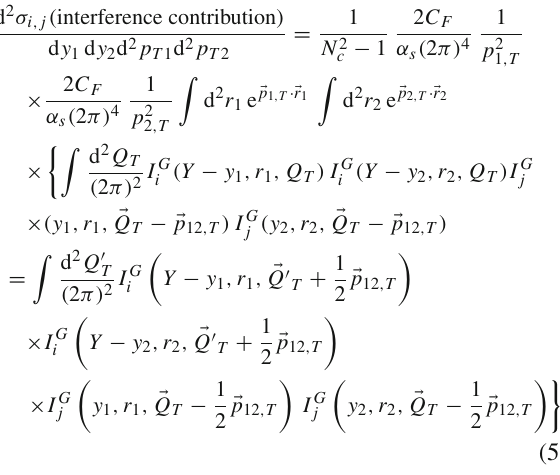
Pomerons in Fig. 3c carry momenta